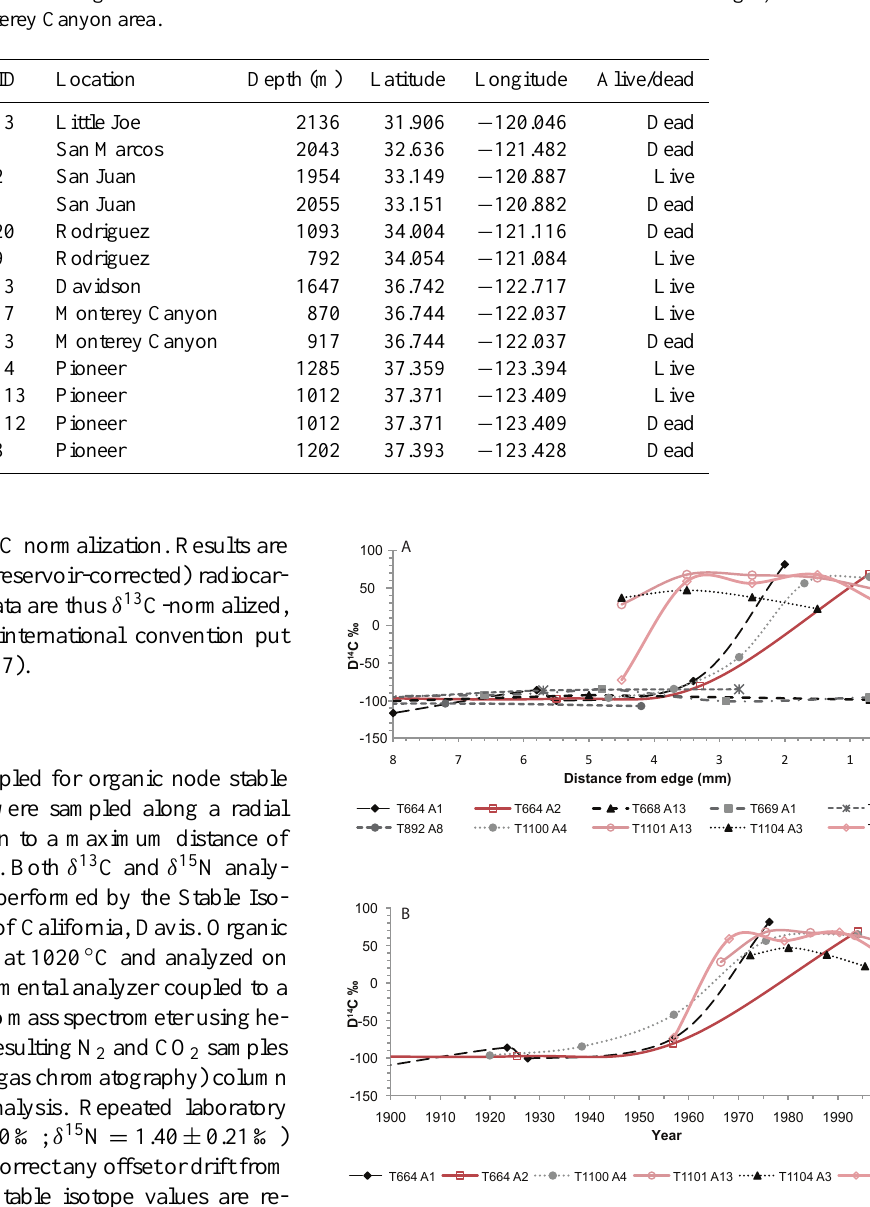
Figure 3. (A) Radiocarbon analyses on live (red symbols) and dead (black or grey symbols) coral specimens, plotted as distance from edge. (B) Radiocarbon analyses on corals with the “bomb spike” apparent, plotted versus age. Coral chronologies are based upon growth rates calculated in Table